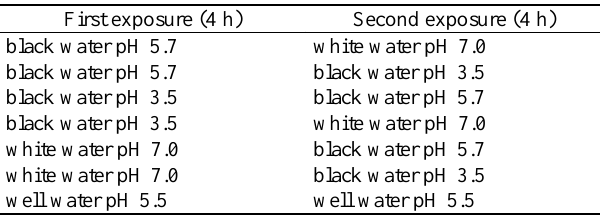
Table 1. Different types of Amazonian waters where Hoplosternum littorale was exposed for determination of